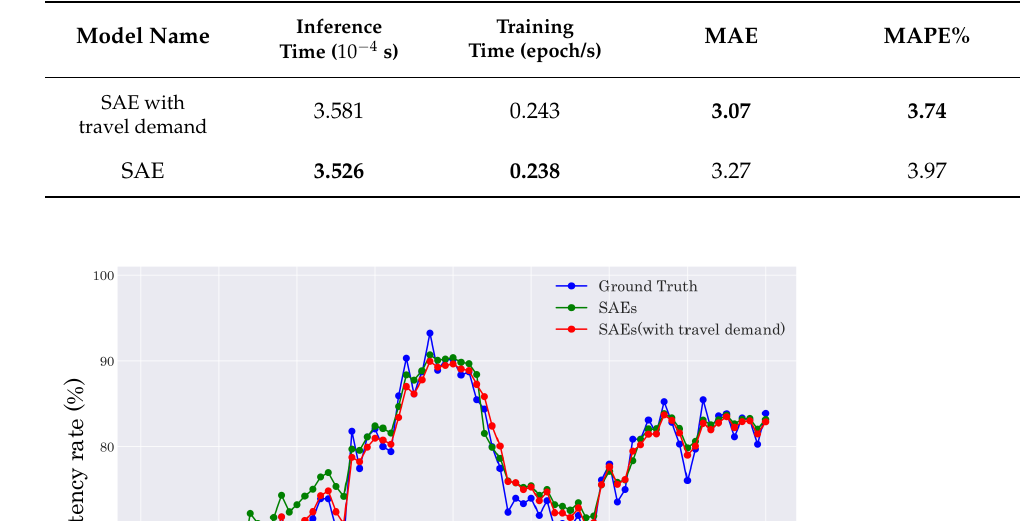
Table 1. Performance of models and Computational cost.